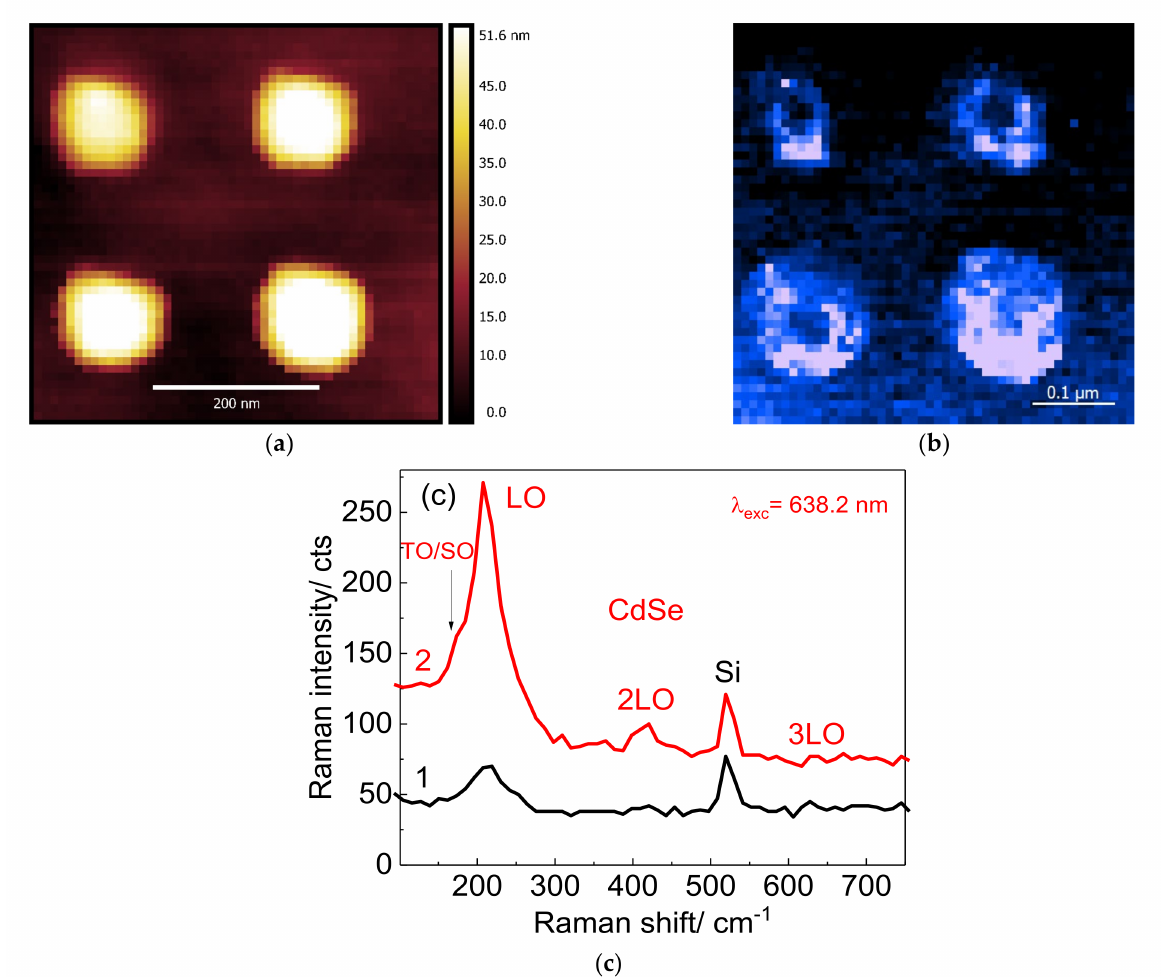
Figure 12. ( a ) AFM image of a nanodisk array covered with a monolayer of CdSe NCs, ( b ) TERS map of LO phonon mode from CdSe NCs measured simultaneously with the AFM image shown in ( a ). The most intense TERS signal in the TERS map comes predominantly from edges of Au nanodisks. ( c ) Comparison of the TERS spectra of CdSe NCs measured on the flat Si/SiO 2 substrate (black spectrum 1) and at the corner of a nanodisk (red spectrum